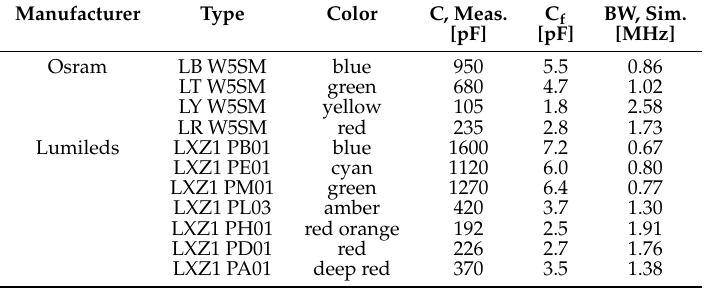
Table 5. LEDs as photodetector, measured capacitance and simulated TIA BW for Q = 0.7, GBP = 210 MHz and R f = 47 k Ω . For comparison: the reference Si PIN PD Osram SFH 2400 has a capacitance of 11 pF at zero reverse voltage, resulting in a simulated BW of 7.8 MHz.